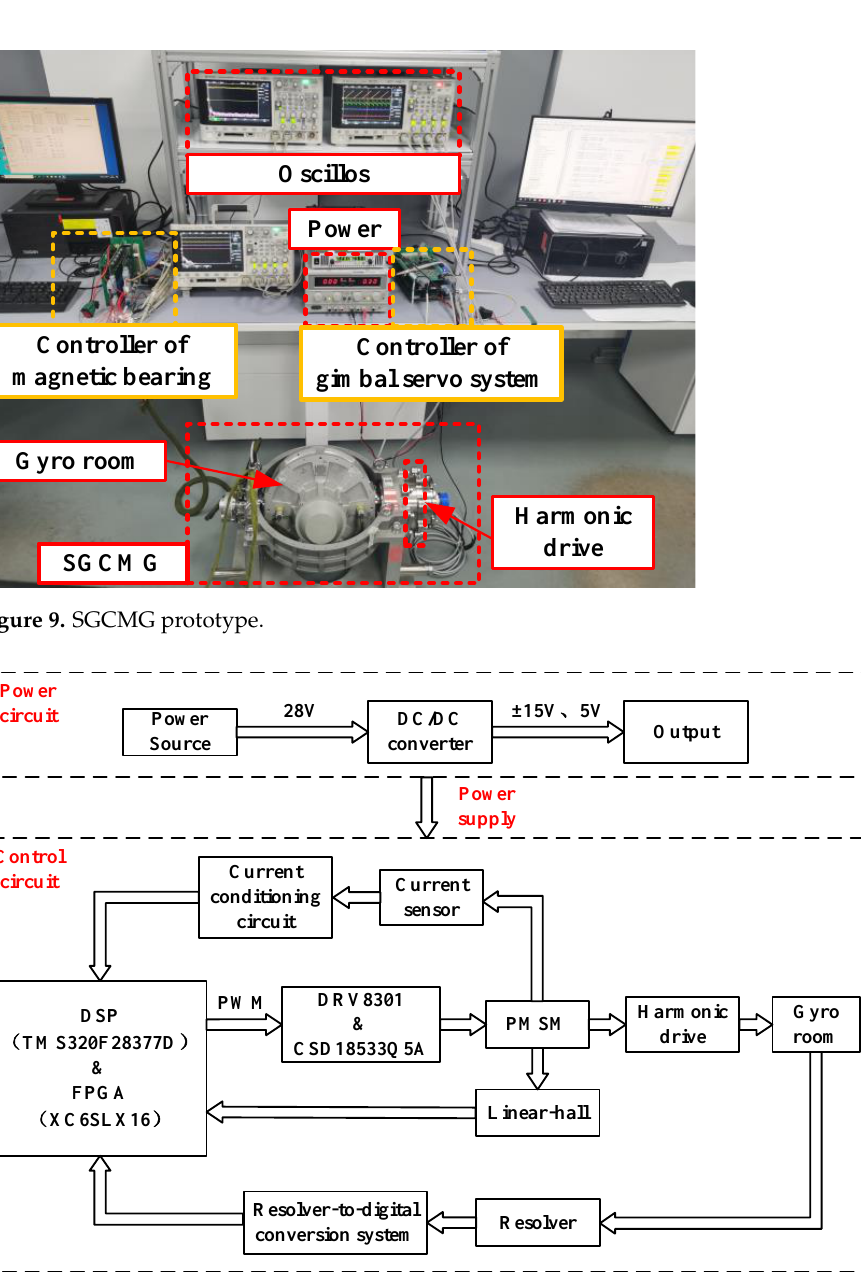
Figure 10. The block diagrams of the experimental